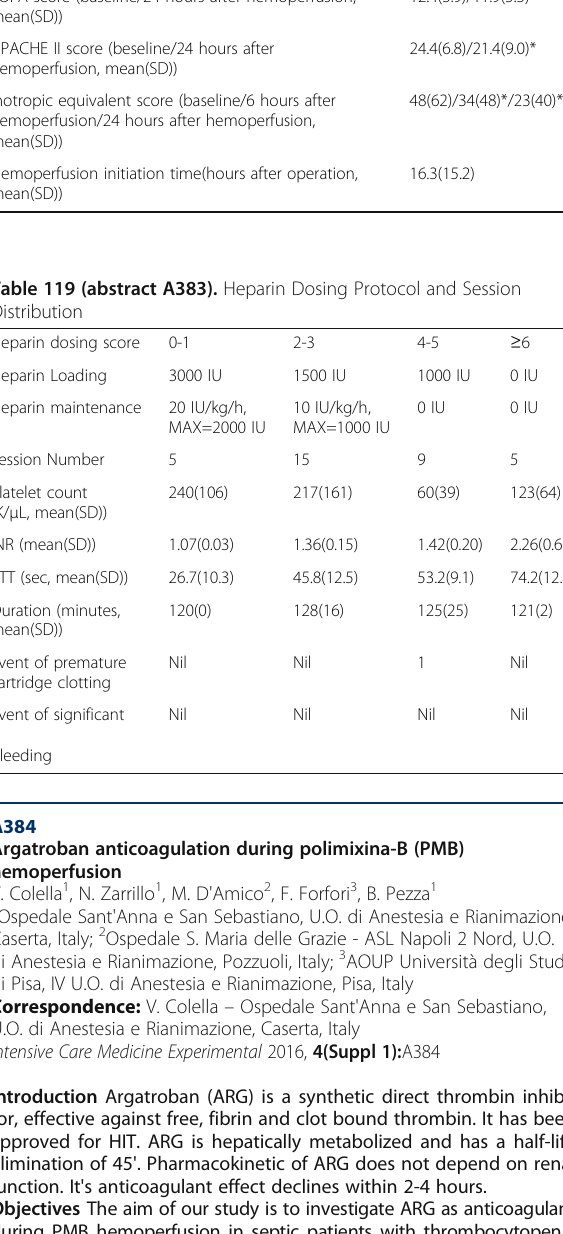
23 patients (34 sessions of hemoperfusion)